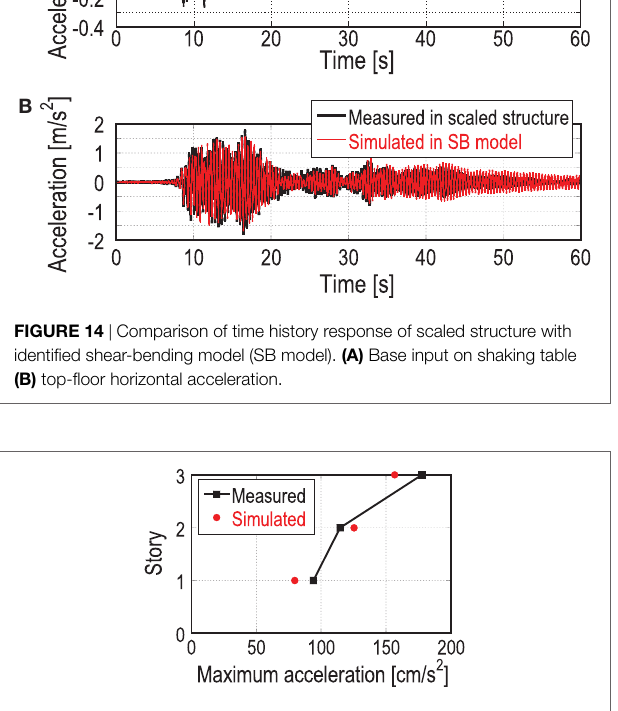
FIGURE 15 | Comparison of maximum accelerations between measured one and simulated